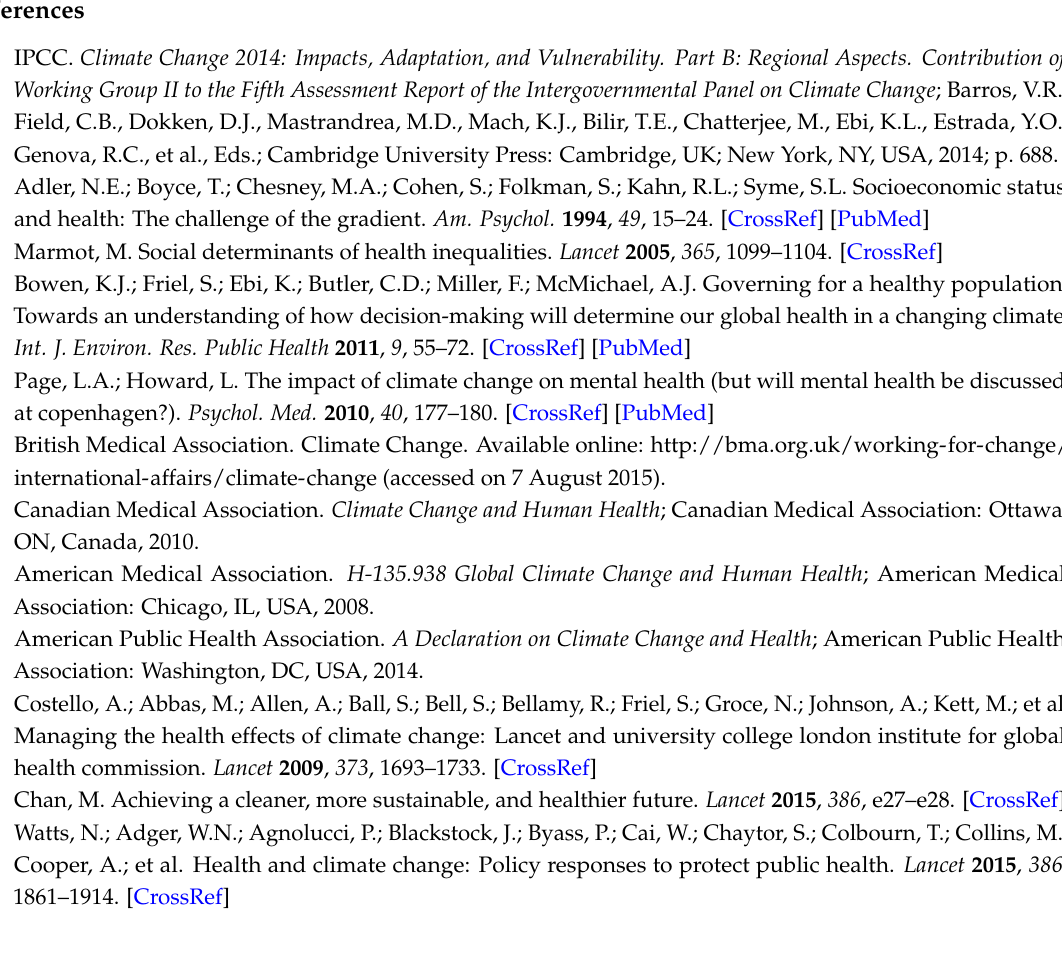
Table S1: Example web search strings used for locating national health adaptation initiatives, Table S2: Inclusion and exclusion criteria for health adaptation documents, Table S3: Adaptation planning documents or government webpages included, Table S4: Public health adaptation initiatives reviewed by adaptation type or sub-category of adaptation type, Table S5: Departments, agencies or other bodies involved in planning or implementing health adaptation initiatives reviewed, Table S6: Background information on included countries’ adaptation planning and health